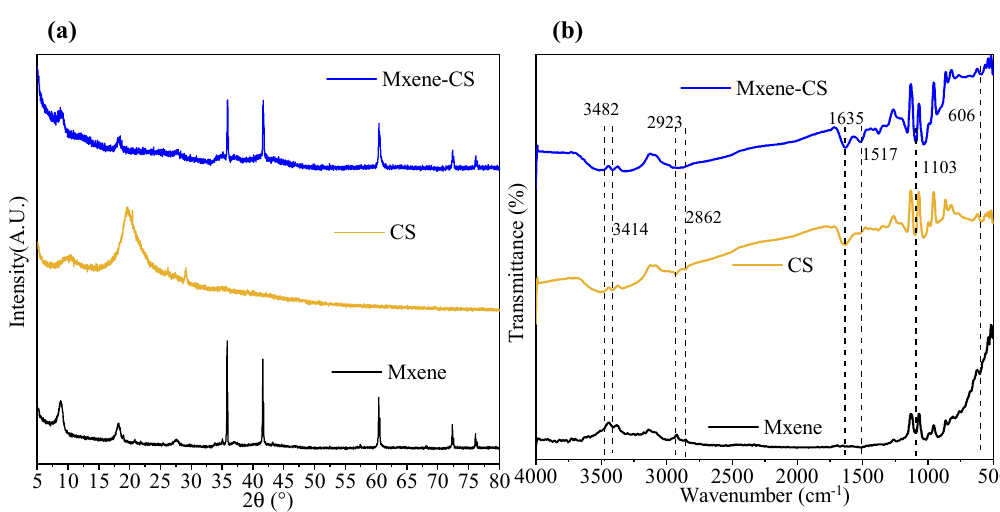
Figure 3. (a) XRD patterns of Mxene, CS, and prepared Mxene–CS. ( b ) FT–IR spectra of Mxene, CS, and prepared Mxene–CS.